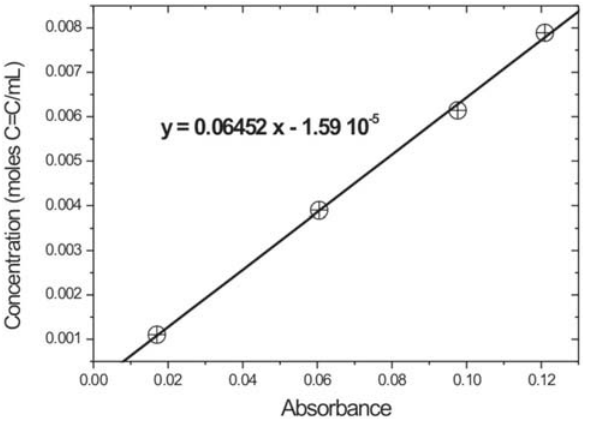
FIGURE 6- Standard or calibration curve obtained with a monomer of ACRON MC composite